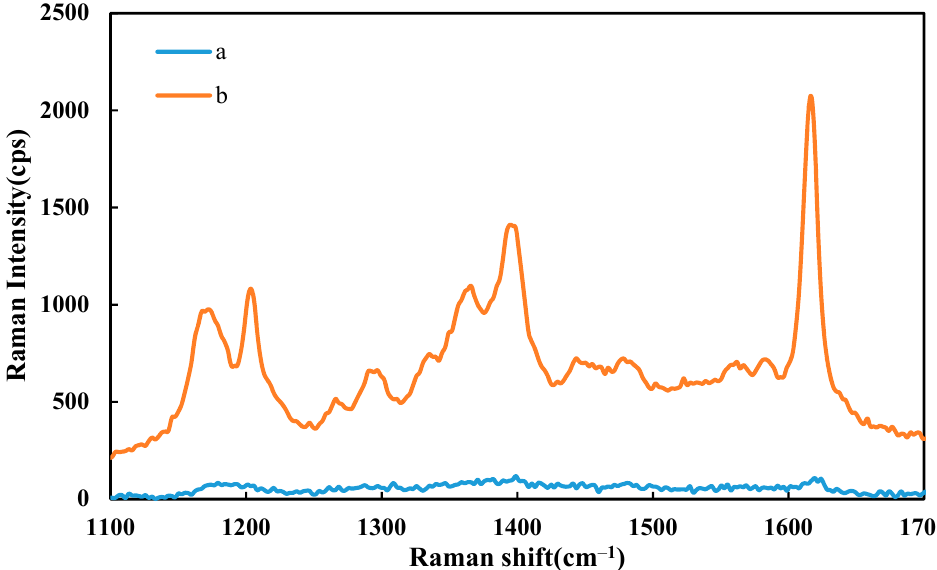
Figure A5. Normal Raman and SERS spectra of the VBB. ( a ) Normal Raman spectra of 0.1 mol/L VBB solution. ( b ) SRES spectra of catalysis system: 0.080 g/L HAuCl 4 + 0.230 mmol/L HCl + 2.00 g/L PEG600 + 0.450 mmol/L DdBd + 0.625 μ mol/L VBB.